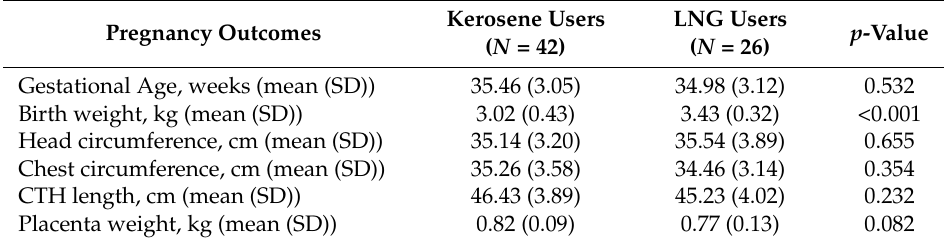
Table 2. Pregnancy outcomes of mothers by cooking fuel group. Pregnancy